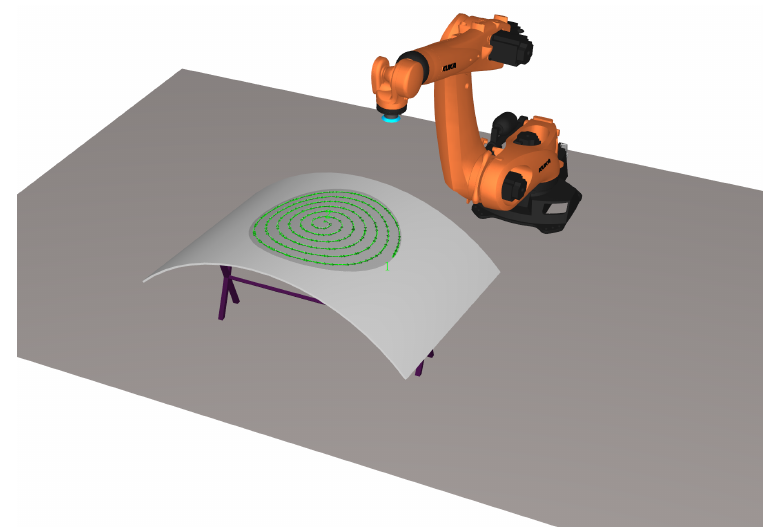
Figure 18. The grinding process of the weld reinforcement.